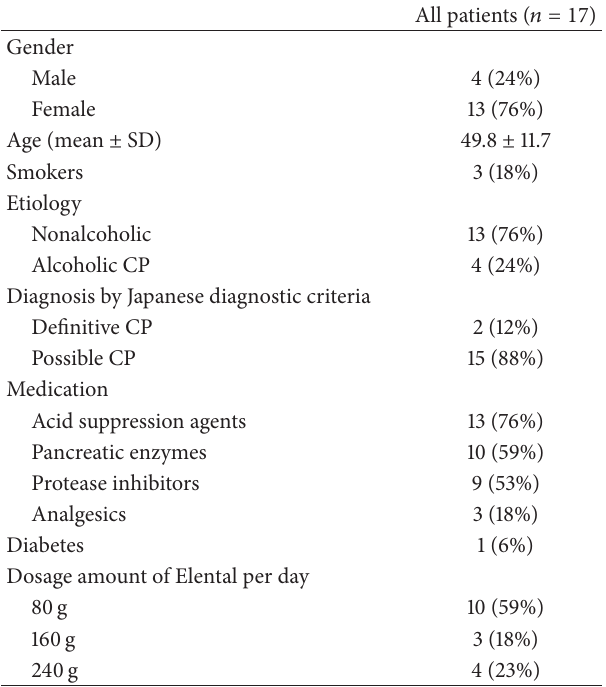
Table 2: Characteristics of analyzed